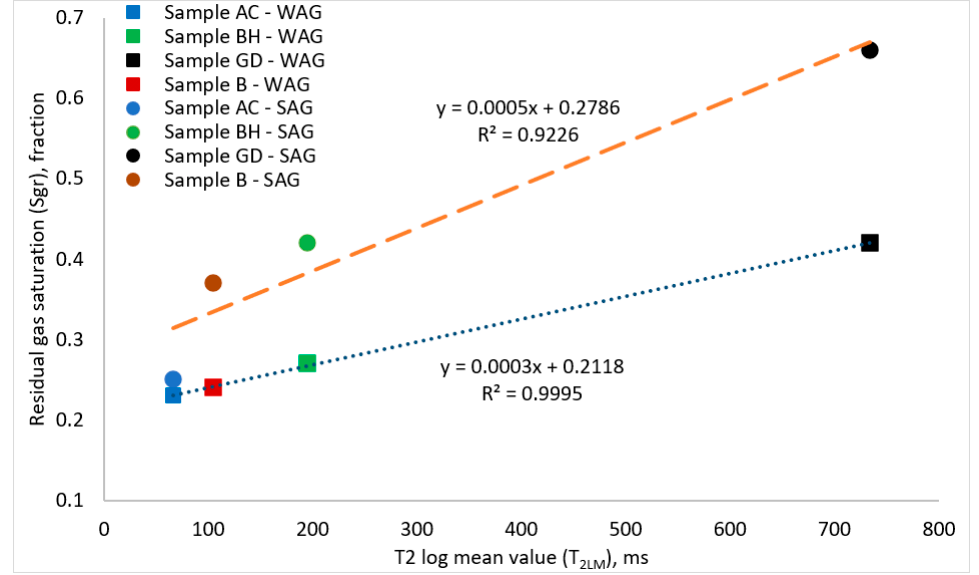
Figure 9. Residual gas saturation versus T 2 log mean values measured in the core samples for both the WAG and SAG injection processes.